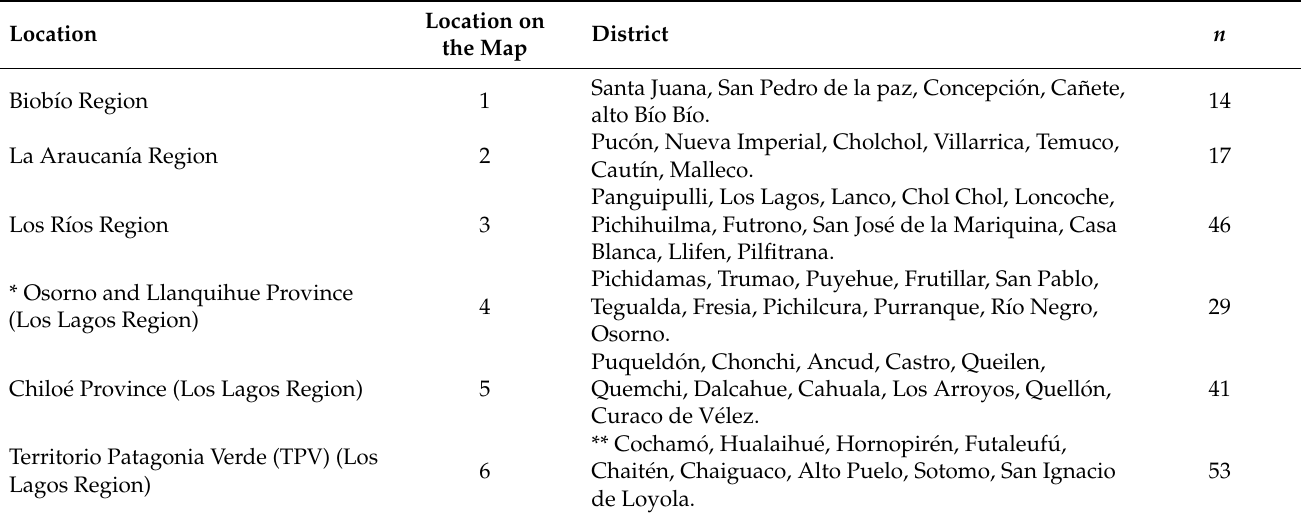
Table 1. Distribution and number of honey samples analyzed.